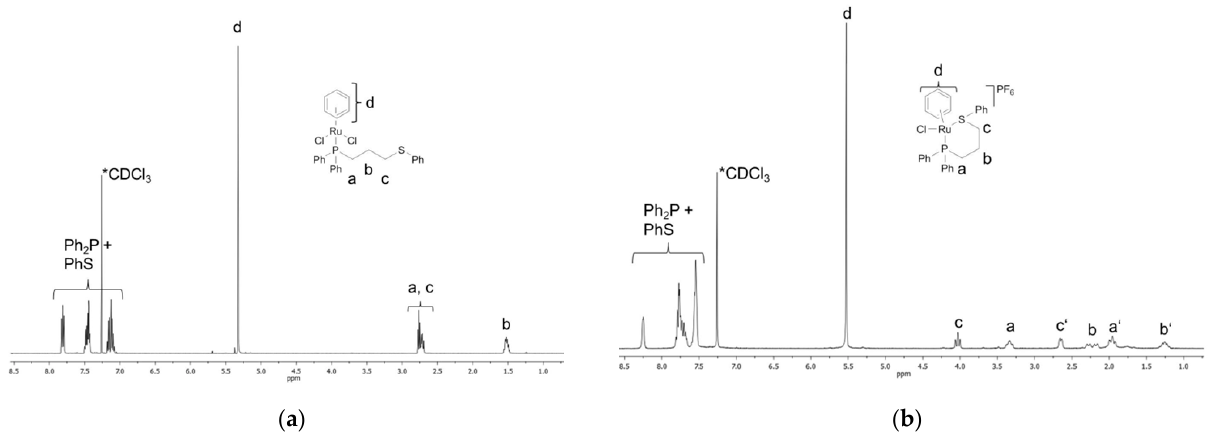
Figure 3. 1 H NMR spectra of Ph 2 P(CH 2 ) 3 SPh, 2a and 4a , as an example. * solvent.